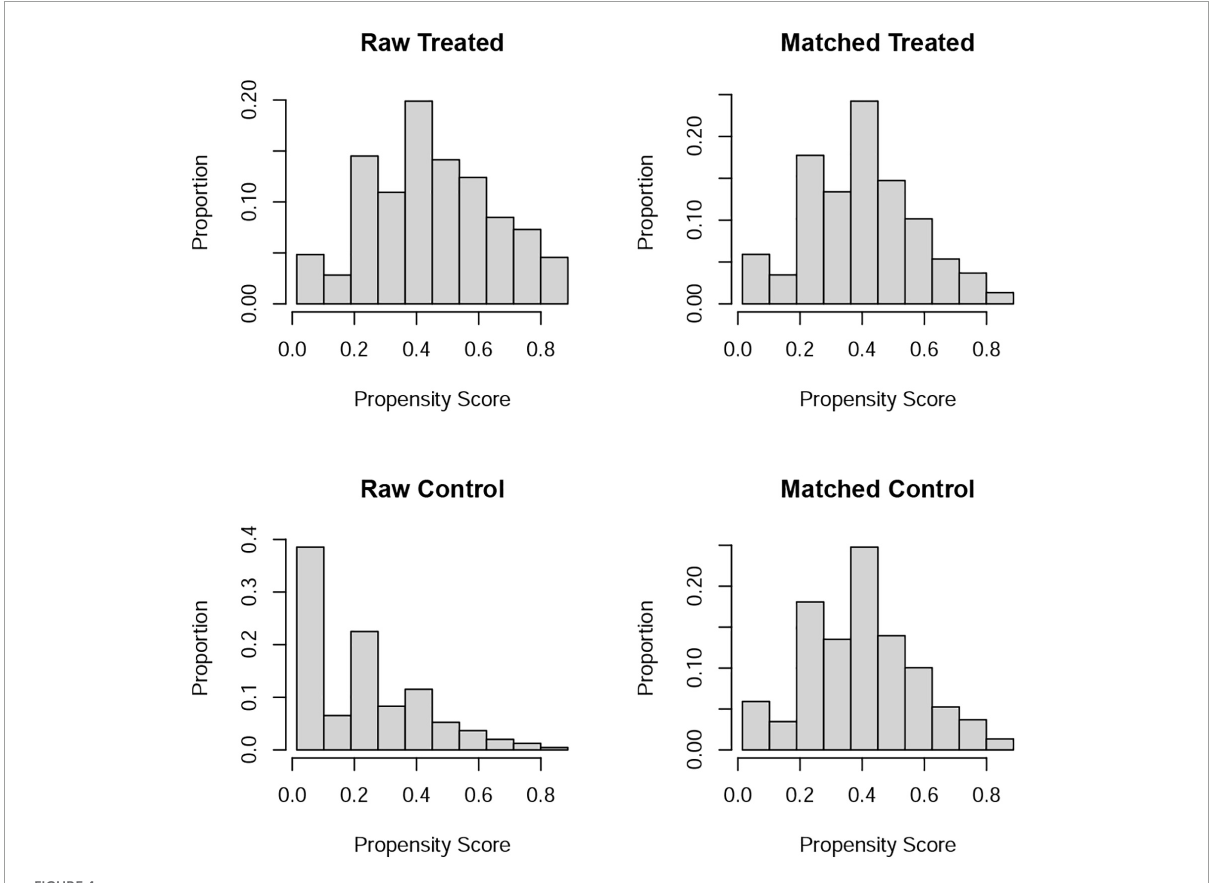
FIGURE4 Propensity score matching analysis for treated and control